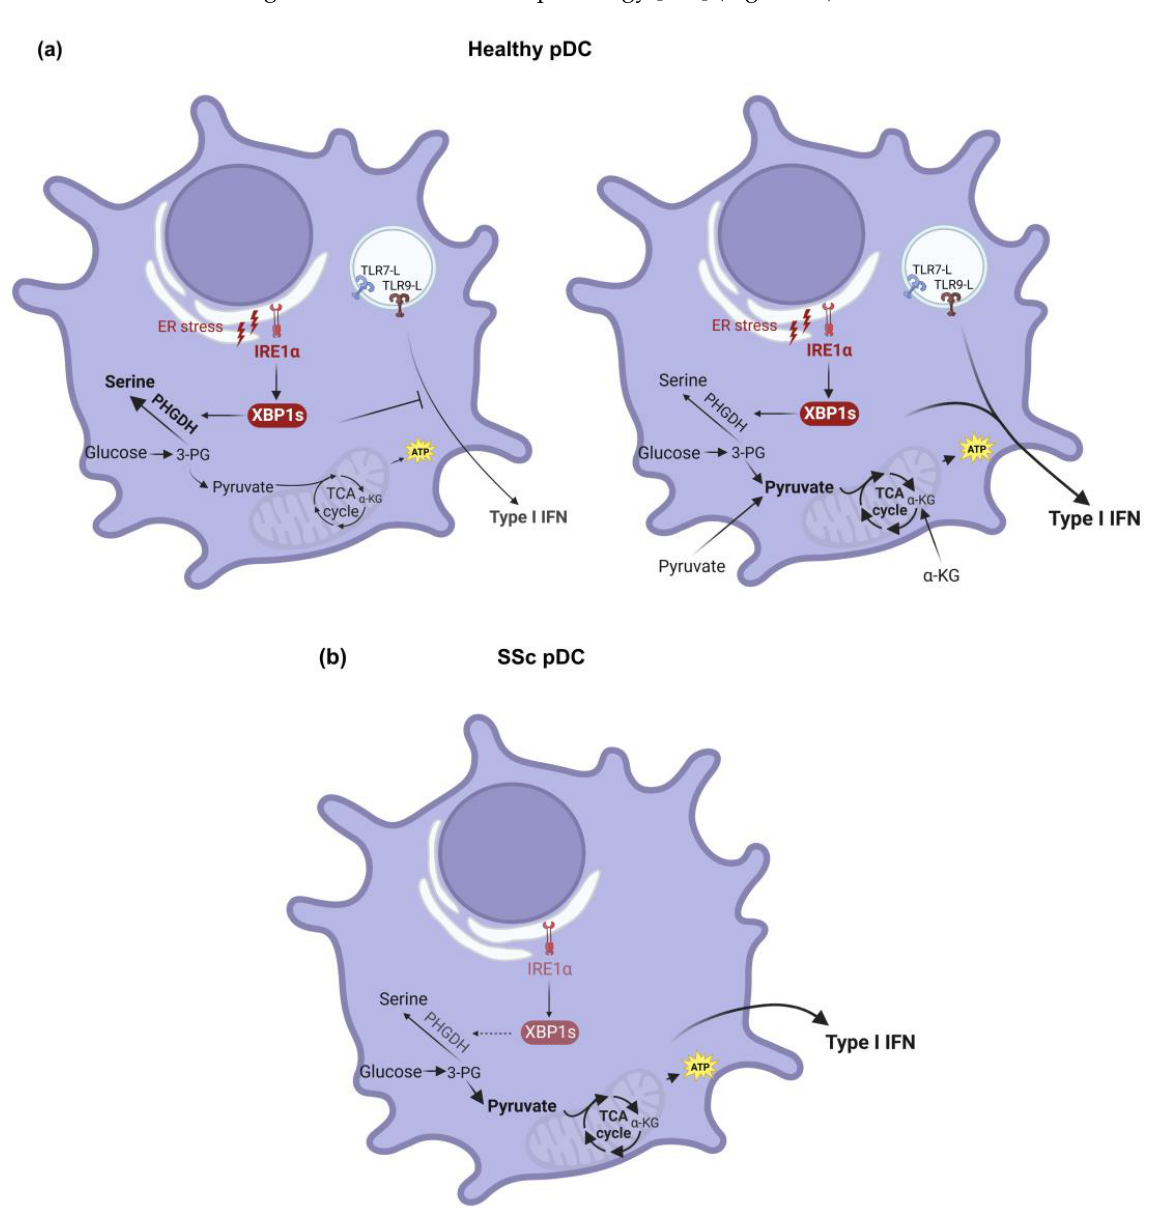
Figure 2. The role of ER stress in type I IFN production by human pDCs. ( a ) pDCs that are